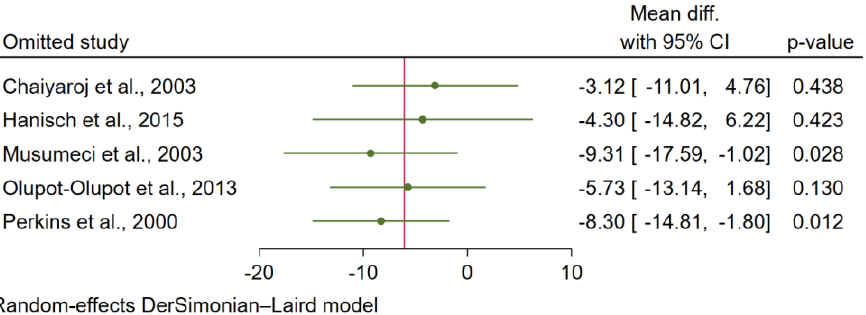
Figure 7. Sensitivity analysis determining the robustness of the meta-analysis results of the differ- ence in TGF-β levels (pg/mL) between severe and uncomplicated malaria [26,27,40–42].